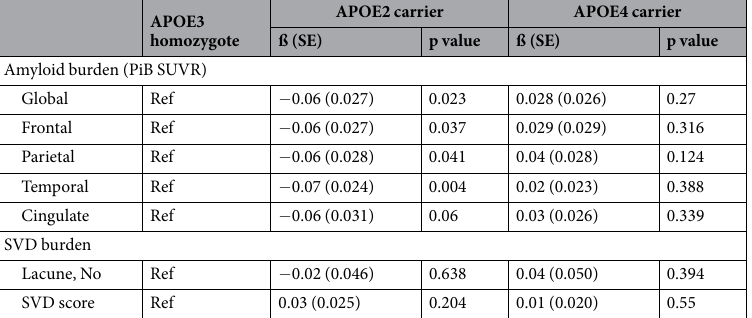
Table 2. Relationships between APOE genotype and the progression rate of PiB SUVR, lacune number, or SVD score. Generalized estimating equation with linear model was conducted with regional PiB SUVR, lacune number, or SVD score as the dependent variables and APOE genotype as the independent variables after controlling for age and gender. APOE = apolipoprotein E; PiB = Pittsburgh compound B; SUVR = standardized uptake value ratio; SVD = small vessel disease; No. = number; β = unstandardized beta coefficient; SE = standard error; Ref = reference.